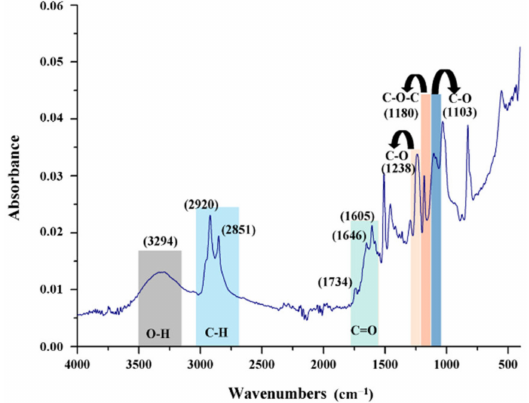
Figure 7. FT-IR characteristic peaks for MWCNT.